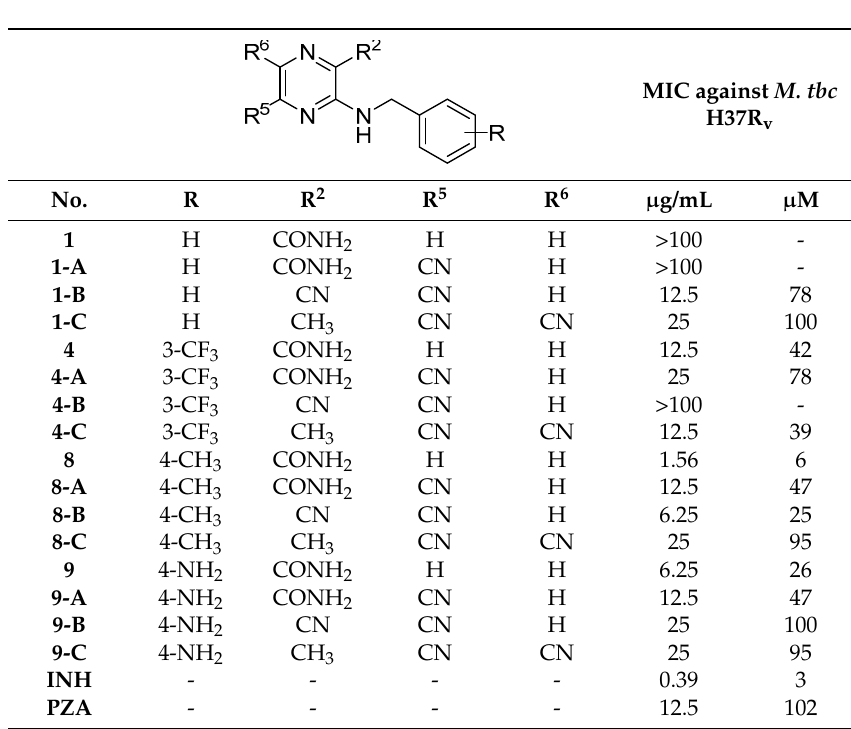
Figure 2. Dependency of antimycobacterial activity (1/MIC) on experimental parameter of lipophilicity log k .